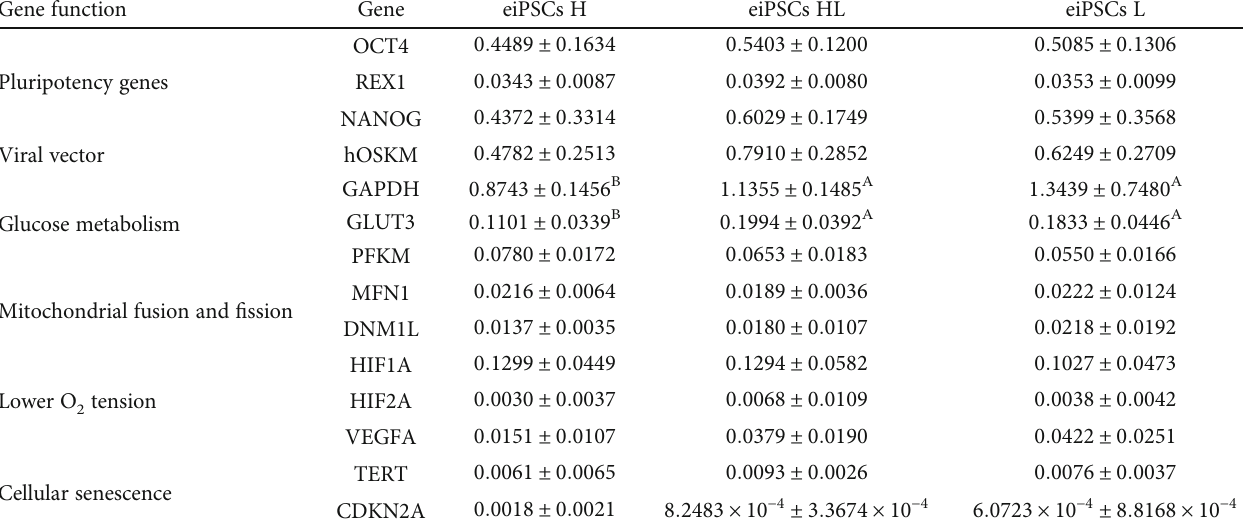
Table 6: Gene expression analysis comparing the three oxygen treatments, eiPSCs H (20% O (5% O 2